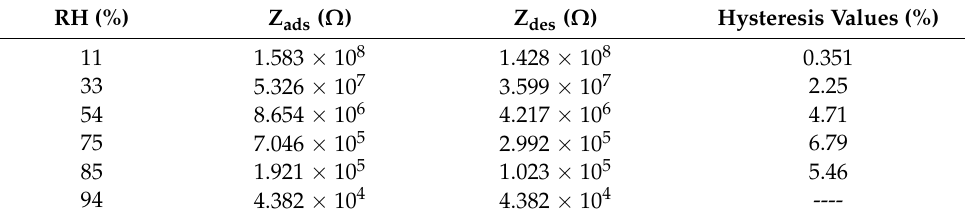
Table 3. Humidity hysteresis values of the sensor based on nanosized